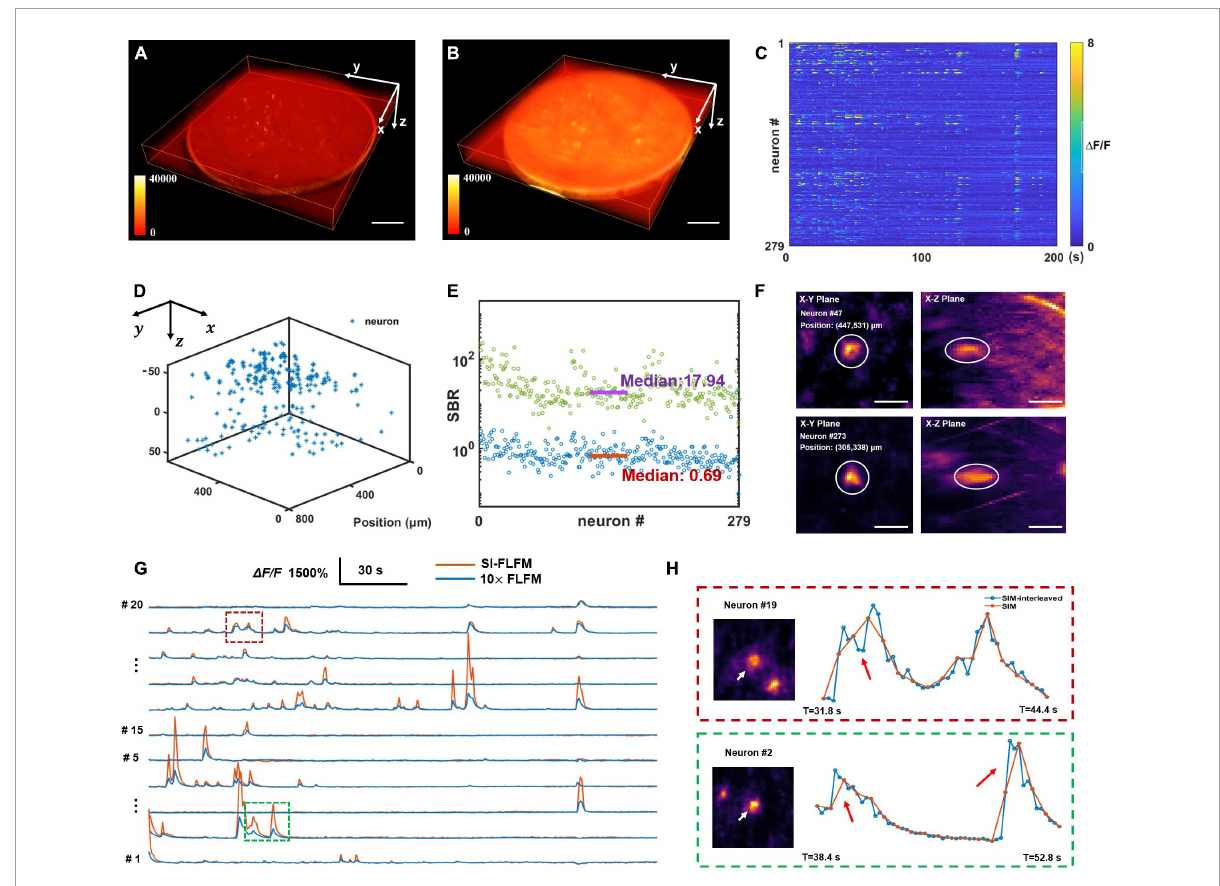
FIGURE5 High-speed volumetric imaging of neural network activity in mouse brains in vivo with high SBR. (A,B) MIPs over time in the four-dimensional domain ( x-y-z-t ), processed in SI-FLFM and FLFM modes, respectively. Scale bar: 100 µ m. (C) Fluorescence signal maps of detected neurons, based on the results in SI-FLFM mode. (D) 3D positions of detected neurons. (E) Statistic of SBR over all neurons in both SI-FLFM (Green dots) and FLFM (Blue dots) modes. The median values are 17.94 and 0.69 in SI-FLFM and FLFM modes, respectively. (F) 3D view images of neurons (neuron #47 and neuron #273) in mouse cortex after MIP over time. Scale bar: 20 µ m. (G) Comparison of the selected neurons’ fluorescence signals in SI-FLFM and FLFM modes. The latter is magnified by a factor of 10. (H) Enlarged profiles of the inset boxes in panel (G) . The additional intensity traces help to avoid artifacts in functional imaging, such as the numbers (red box labeled) and the accurate times (green box labeled) of neuronal firings. Scale bar: 20 µ